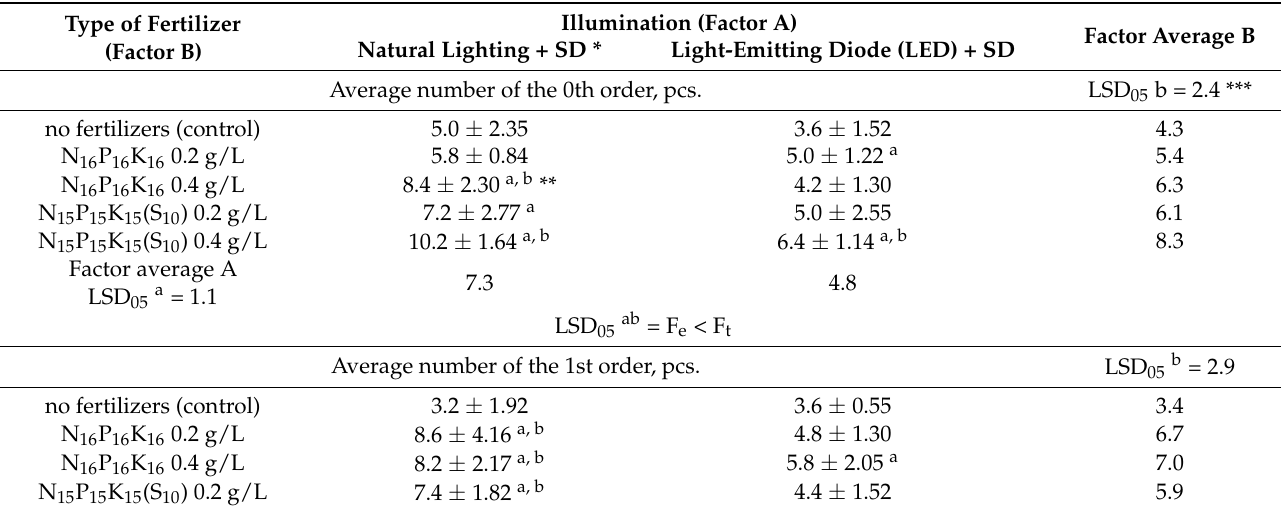
Table 6. Morphometric indicators of ex vitro development in highbush blueberry ( Vaccinium corymbo- sum L.) plants cv. Brigitta Blue on the 112th day of growing